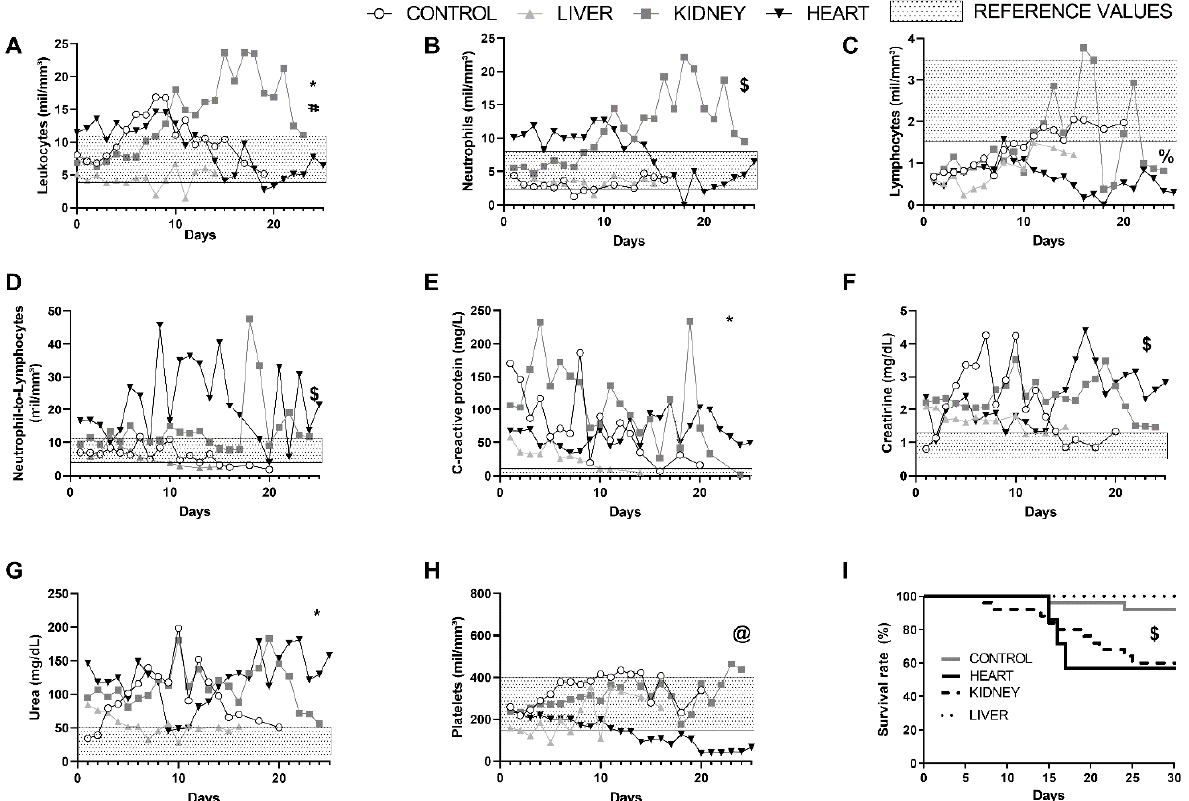
Figure 1. Daily clinical features of COVID-19 patients of the CONTROL, LIVER, KIDNEY, and HEART groups. ( A ) Leukocytes, ( B ) neutrophils, and ( C ) lymphocyte counts, ( D ) ratio of neutrophils-to-lymphocytes, ( E ) C-reactive protein, ( F ) creatinine and ( G ) urea levels, ( H ) platelet count, and ( I ) survival analysis. CONTROL, non-SOT recipients with COVID-19; LIVER, liver transplant recipients with COVID-19; KIDNEY, kidney transplant recipients with COVID-19; HEART, heart transplant recipients with COVID-19. * p < 0.05 difference from LIVER to all other groups. # p < 0.05 difference from KIDNEY and HEART. $ p < 0.05 difference from CONTROL and LIVER to all other groups. % p < 0.05 difference from HEART in comparison to CONTROL and KIDNEY. @ p < 0.05 difference from HEART in comparison to all other groups. Statistical analysis: In ( A – G ) was used Kruskal–Wallis test with Dunn’s multiple comparisons was used and in ( H ), Log-rank test for trend. Data were collected between 1 May 2020 and 31 July